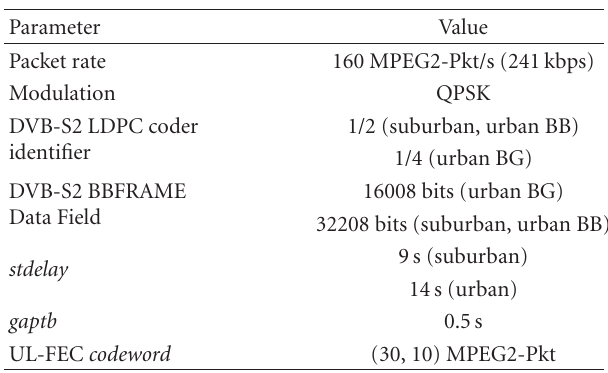
Table 3: Simulation